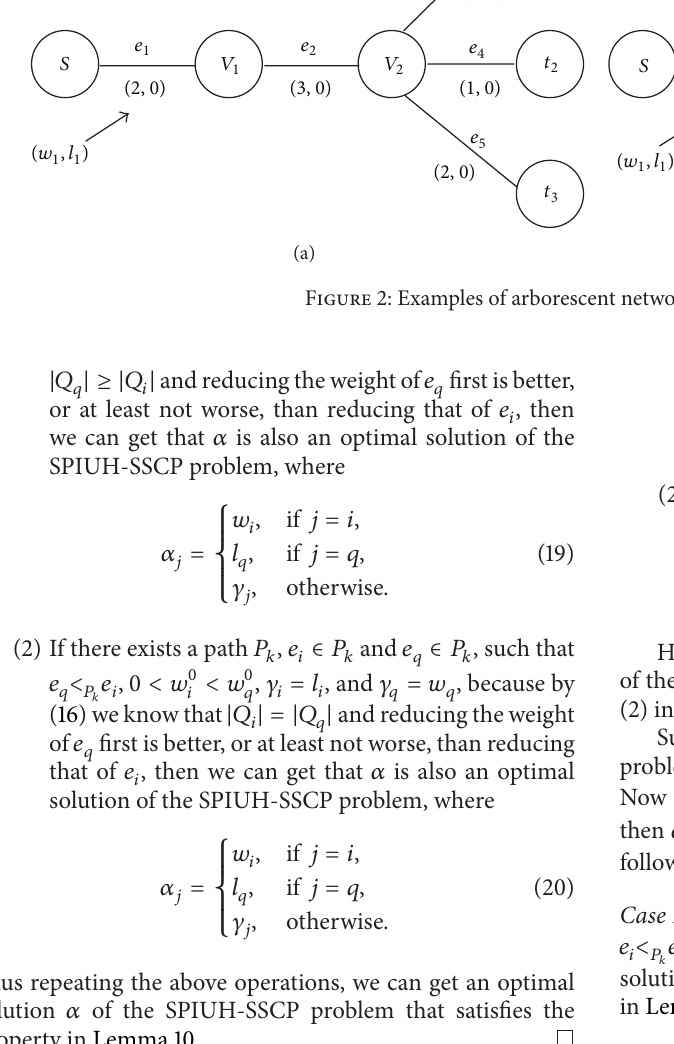
Algorithm 9 outputs an optimal solution 𝑤 ∗ of the SPIUH- SSCP problem in 𝑂(𝑚(𝑟 + log 𝑚))